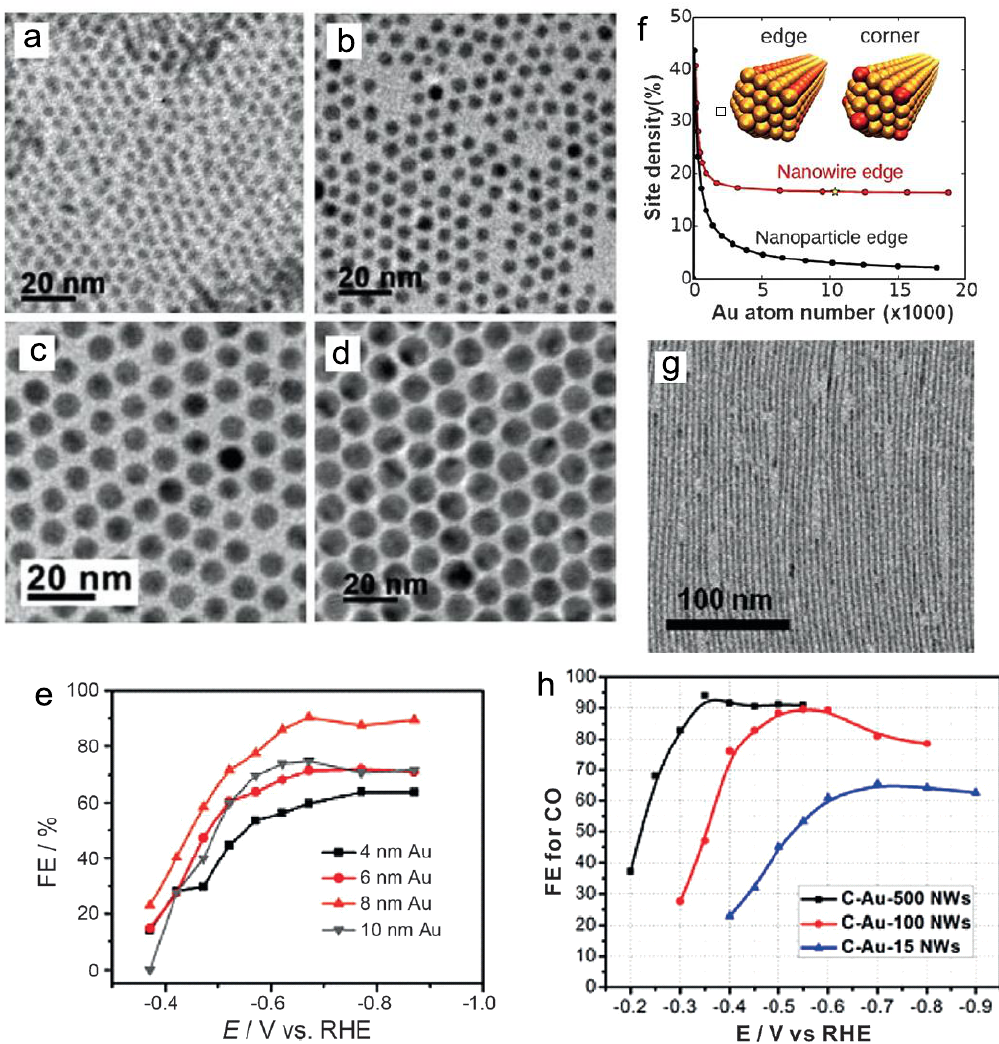
Figure 1. ( a – e ) Transmission electron microscope (TEM) images and potential-dependent Faradaic efficiencies of the 4, 6, 8, and 10 nm Au nanoparticles (NPs). Adapted with permission from Ref. [30]. Copyright 2013 American Chemical Society. ( f ) Edge site weight percentage for the Au nanowires and NPs. ( g , h ) TEM image and potential-dependent Faradaic efficiencies of the Au nanowires. Adapted with permission from Ref. [32]. Copyright 2014, American Chemical Society.